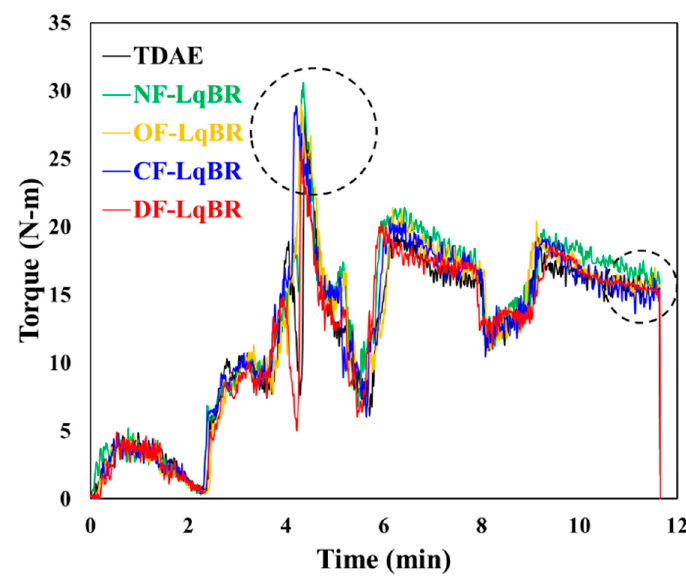
Figure 4. Mixing torque of the compounds during the first stage. Table 5. Peak torque of the compounds during the first stage mixing.